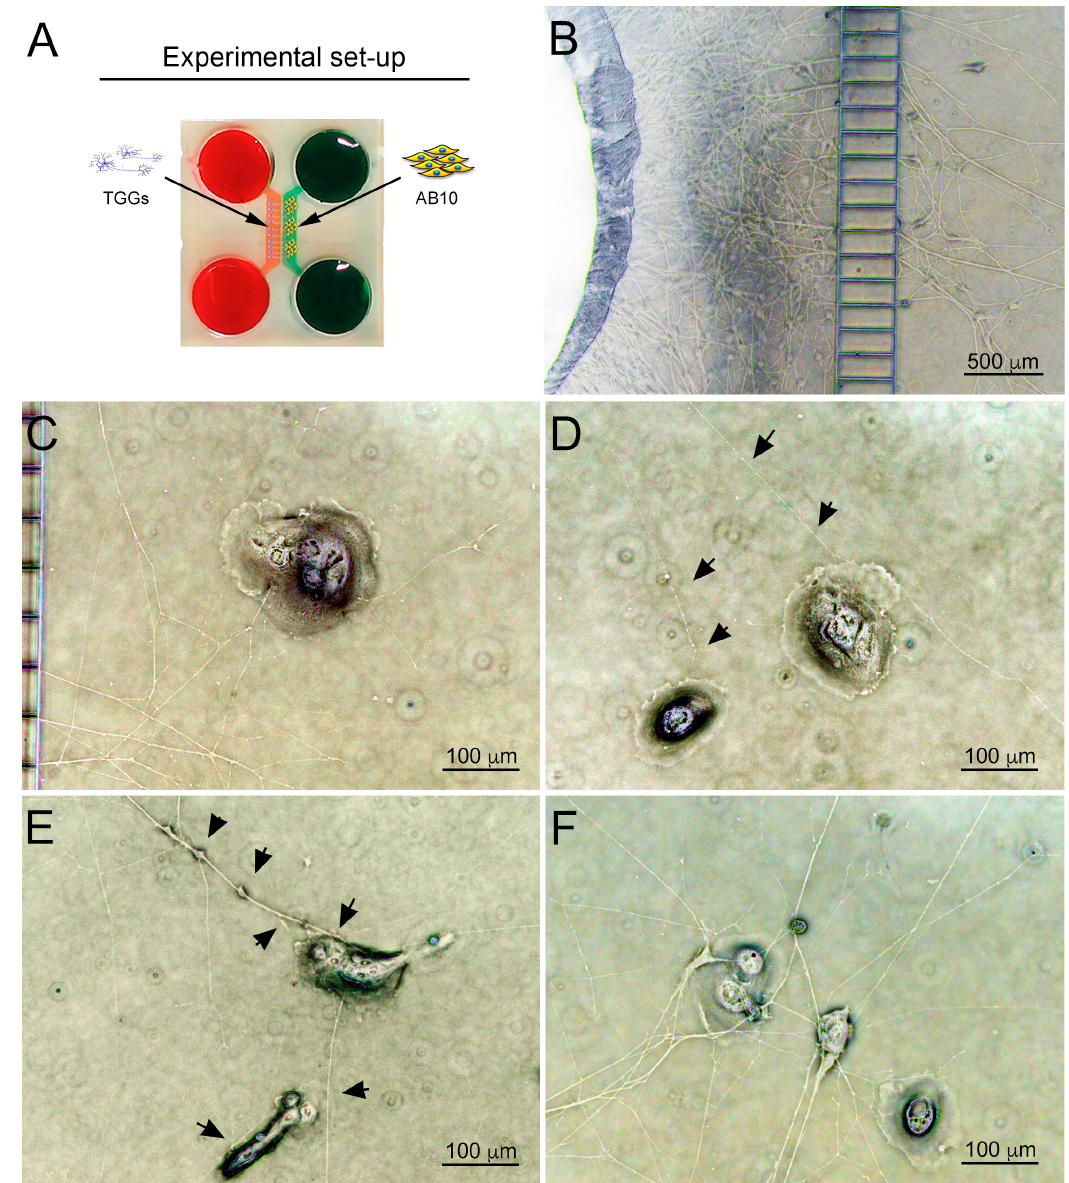
Figure 6. Co-culture of trigeminal ganglia and human AB10 ameloblastoma cells. ( A ) Schematic representation of the experimental set-up. ( B ) Overview of axons crossing the microgrooves and entering the AB10-containing culture chamber. ( C – F ) Brightfield images showing directional growth of axons towards AB10 cells at different distances from the chamber’s borders. Black arrowheads highlight axons growing towards AB10 cells. Scale bars: B: 500 μ m; C–E: 100 μ m.